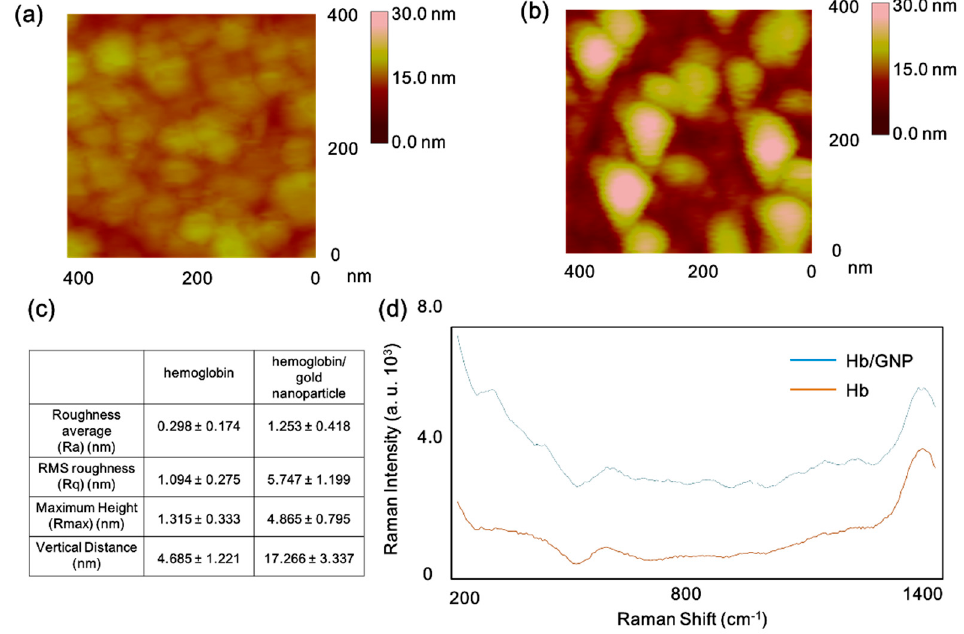
Figure 3. Surface morphology investigation of ( a ) hemoglobin; ( b ) hemoglobin/gold nanoparticle on 6-mercaptohexanoic acid (6-MHA) layer; ( c ) Surface roughness analysis of the hemoglobin, hemoglobin/gold nanoparticle; ( d ) Raman spectra of hemoglobin (Brown line); ( b ) hemoglobin/gold nanoparticle on 6-MHA layer (Blue line).